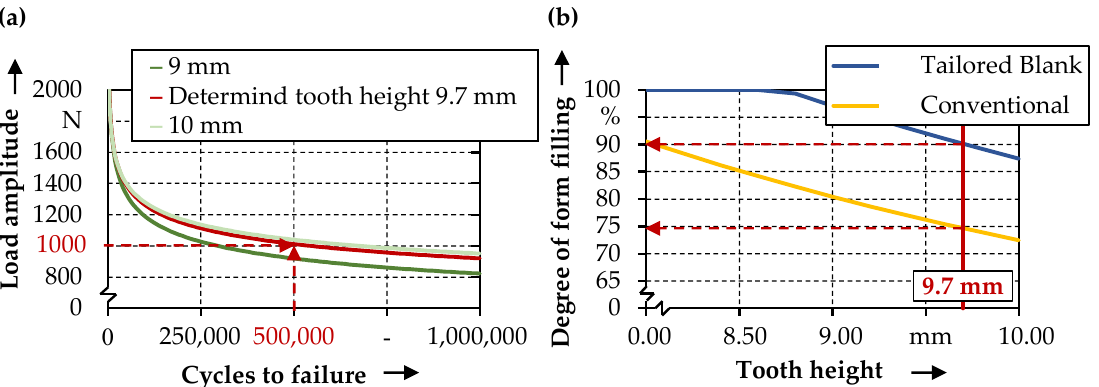
Figure 17. ( a ) Prediction of tooth height for given cycles to failure and load amplitude and ( b ) the respective degree of form filling for conventional and tailored blanks, evaluated by the trained metamodels.